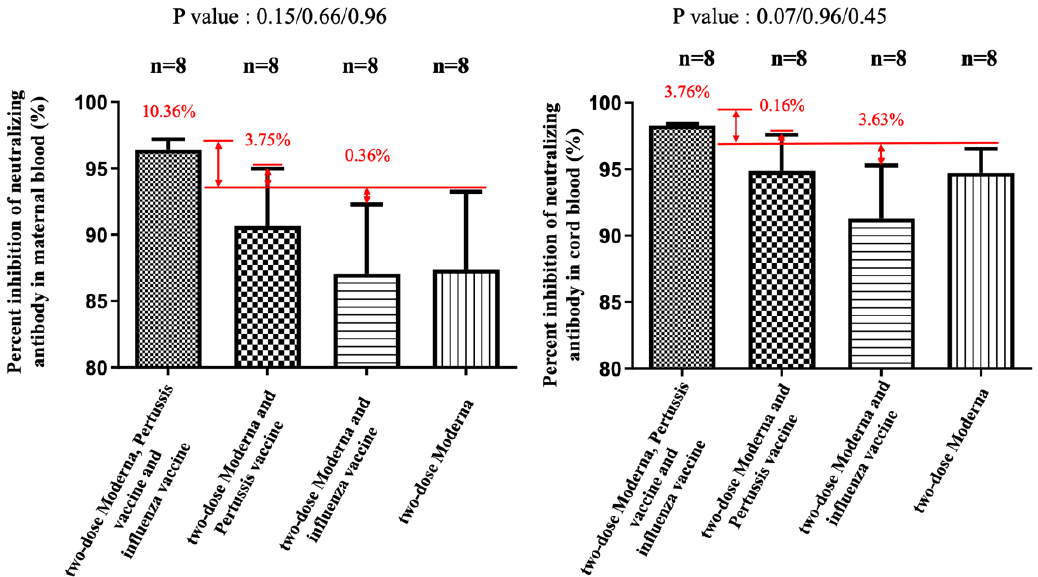
Figure 5. The percentage of inhibition of neutralizing antibody (%) against the wild type in maternal and cord blood. In the Moderna + Tdap + influenza group, there was a 10.36% increase ( p = 0.15) in maternal blood and a 3.76% ( p = 0.07) increase in cord blood compared with the Moderna only. In the Moderna + Tdap group, there was a 3.75% increase ( p = 0.66) in maternal blood and a 0.16% ( p = 0.96) increase in cord blood compared with the Moderna only. In the Moderna + influenza group, there was a 0.36% decrease ( p = 0.96) in maternal blood and a 3.63% reduction ( p = 0.45) in cord blood compared with the Moderna only.